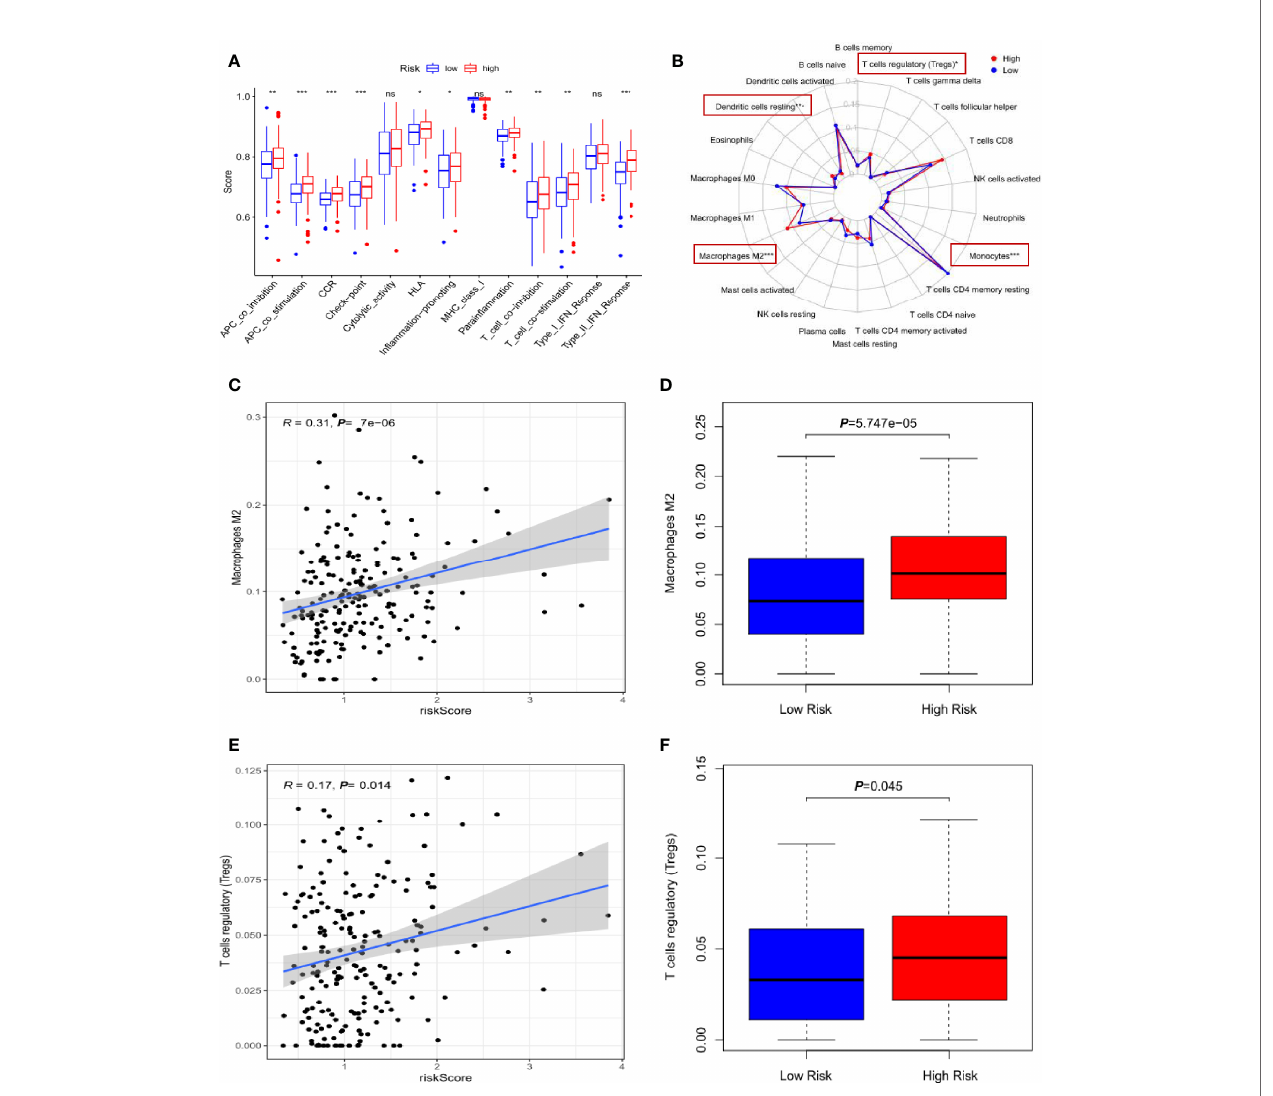
FIGURE 5 | Correlation of the three-lncRNA signature with in fi ltration of immune cells. (A) The comparison of immune-related functions between high- and low-risk groups. (B) The radar map showed the in fi ltration of 22 types of immune cells and the red rectangle boxes indicated the signi fi cant difference. (C) The scatter plot of M2 polarized cells linked to risk score. (D) The relative percentage of M2 polarized cells in high- and low-risk groups. (E) The scatter plot of Treg cells in fi ltration associated with risk score. (F) The relative percentage of Treg cells in high- and low-risk groups. * p < 0.05, ** p < 0.01, *** p < 0.001. NS means non-statistical signi fi